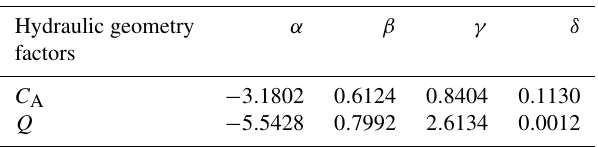
Table A1. Parameters of the scaling coefficients by Dodov and Foufoula-Georgiou (2004).